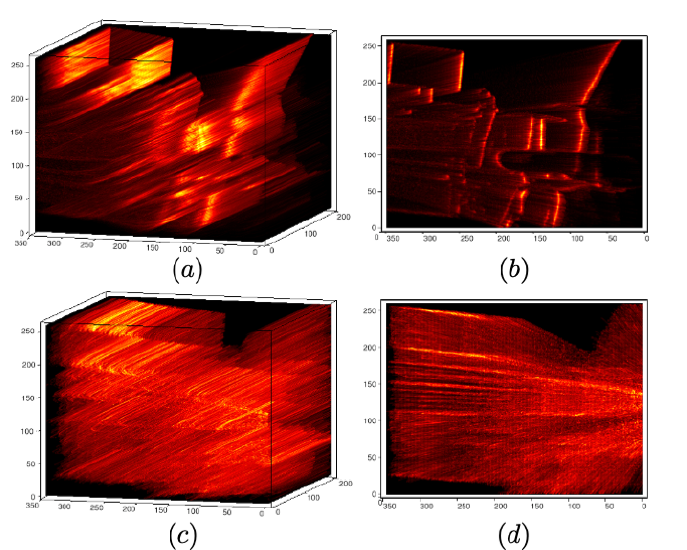
Figure 2. Warped rays with object space distances for an example voxel v mnl .